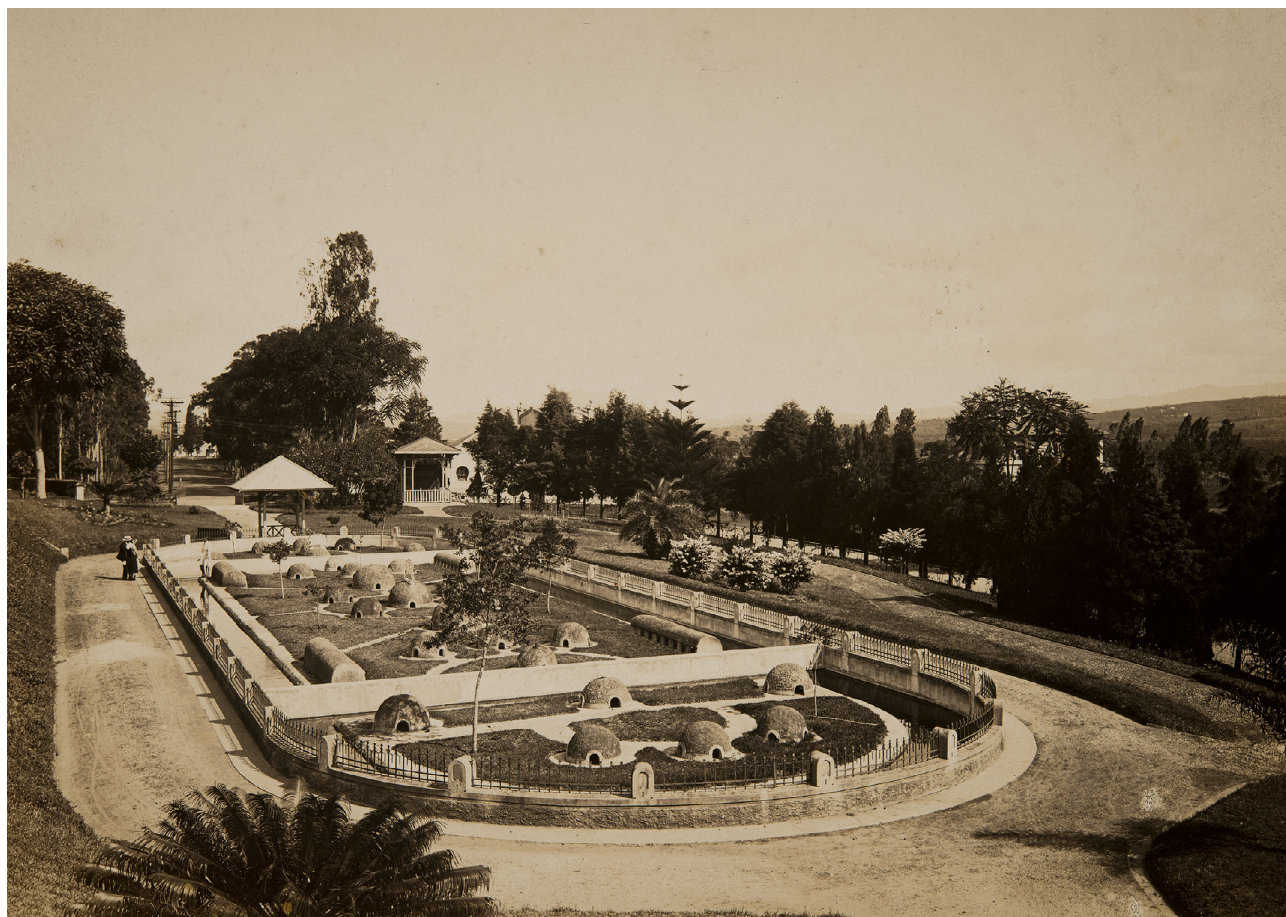
Figure 1. View of the semi-intensive serpentarium in 1926 (photo courtesy of the Memory Center Collection of Butantan